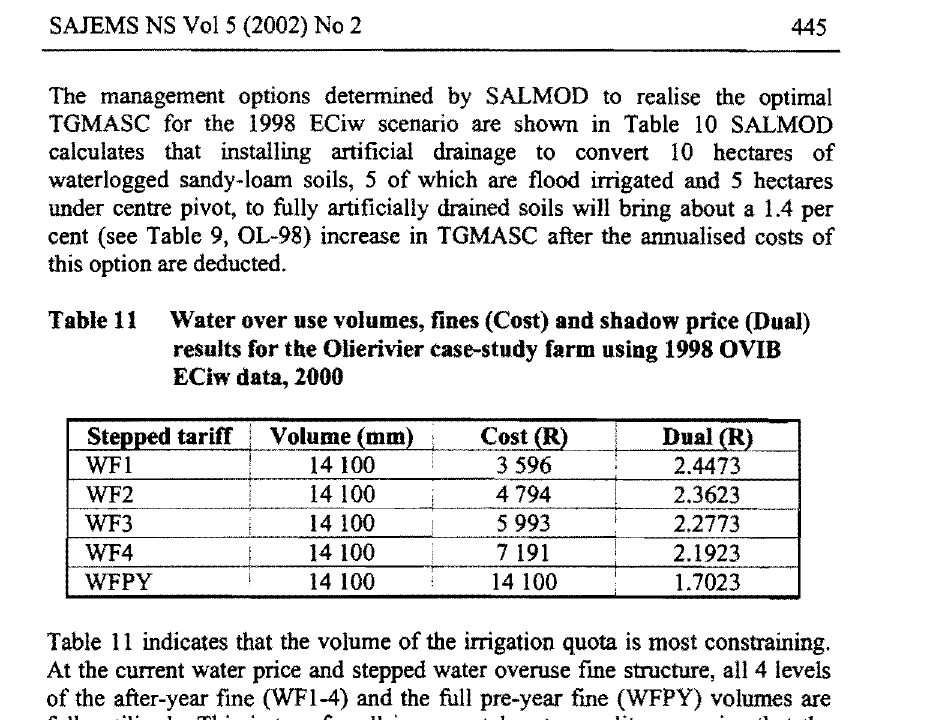
Table 11 indicates that the volume of the irrigation quota is most